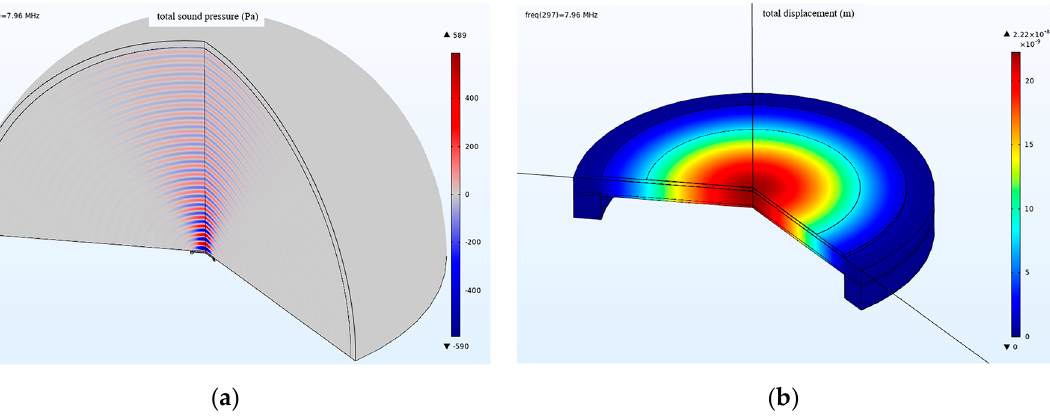
Figure 6. Simulation results of sound-emission performance of PMUT: ( a ) sound-pressure contours of the circular PMUT; ( b ) displacement contours of the circular PMUT in transmit mode.